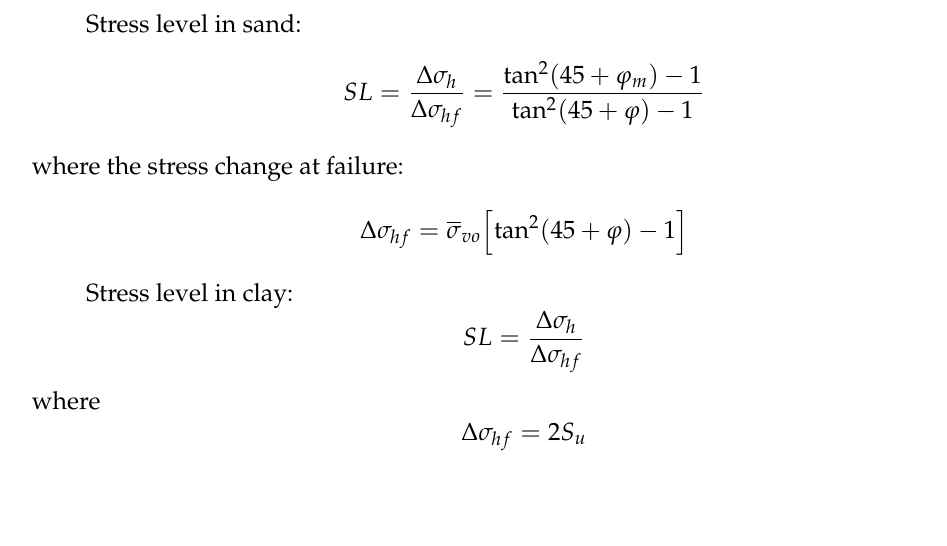
Figure 8. The relationship among the lateral stress change, the stress level, and the friction angle (Modified from Ashour et al. [21]).